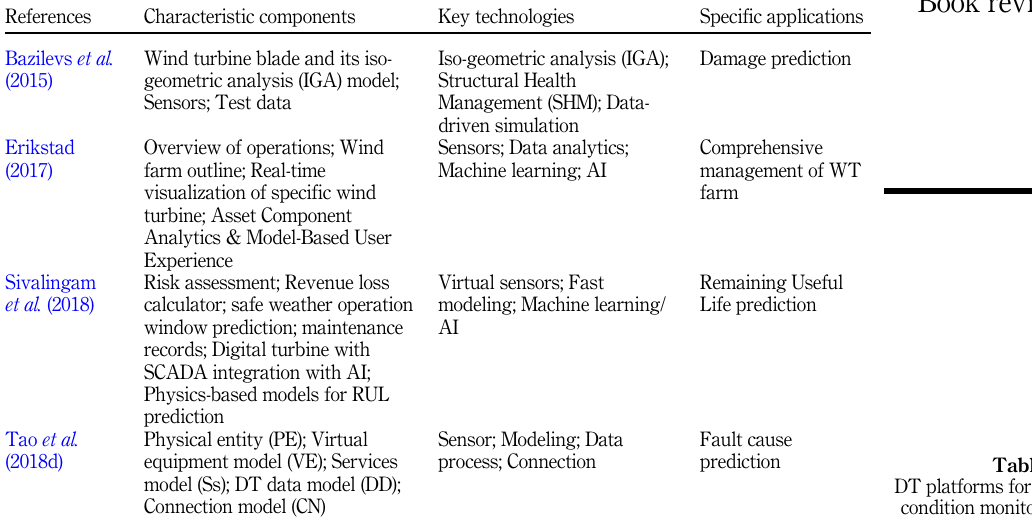
Table 8. DT platforms for